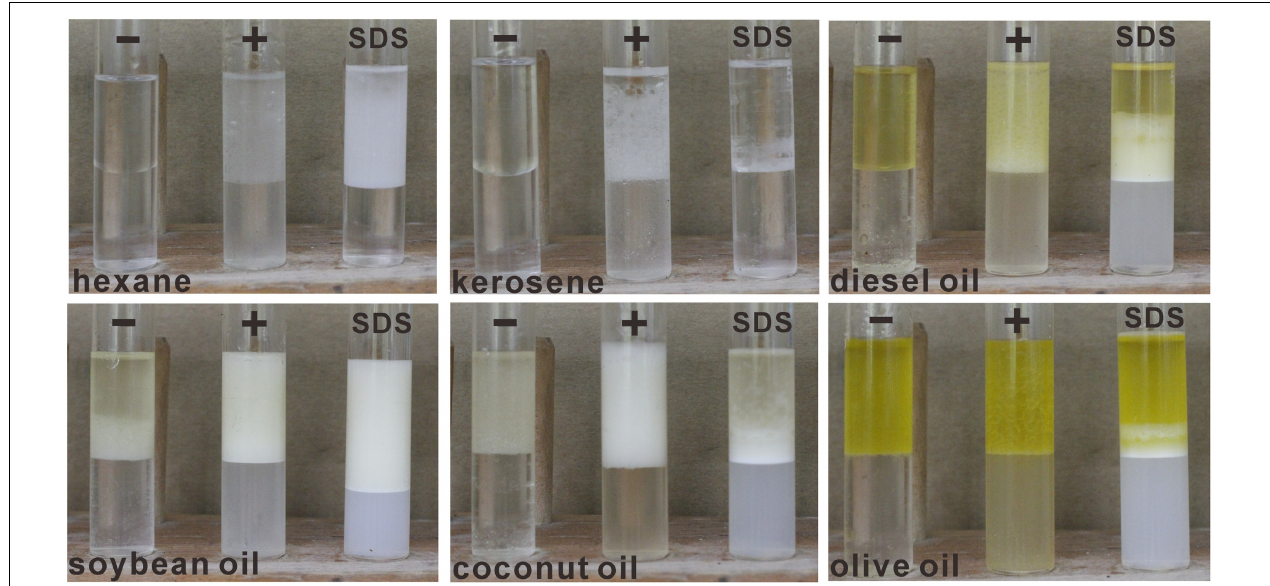
FIGURE 3 | Emulsification activity of the fermentation broth using citric acid as the sole source of carbon and energy. The cell-free supernatant of the fermentation broth was used in the experiments. SDS at the concentration of 0.5 g/L was used as a positive control. − , fermentation medium without bacteria inoculation incubated for 3 days; +, incubation for 3 days with bacteria